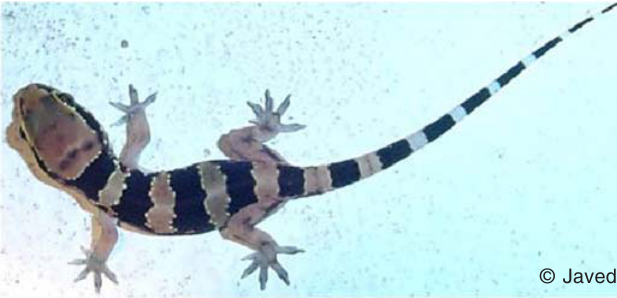
Image 4. Dorsal aspect of Hemidactylus triedrus juvenile in